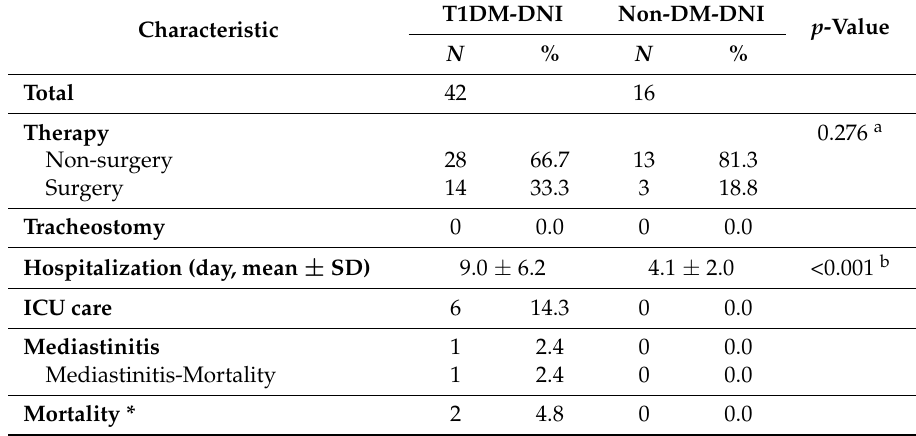
Table 3. Treatment modalities, complications, and prognostic outcomes in patients with DNI. Characteristic